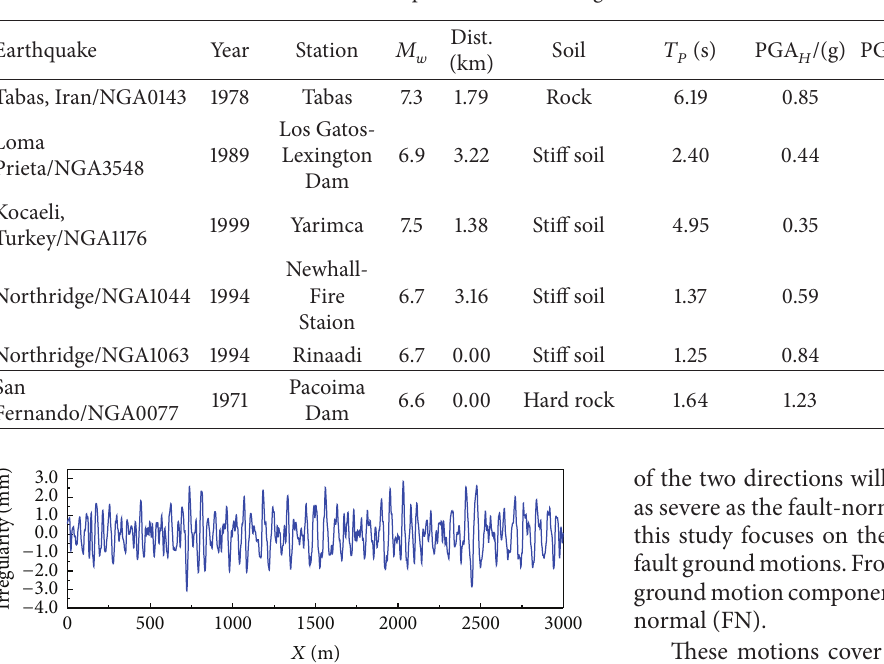
Table 4: Properties of near-fault ground motions used in the analyses.